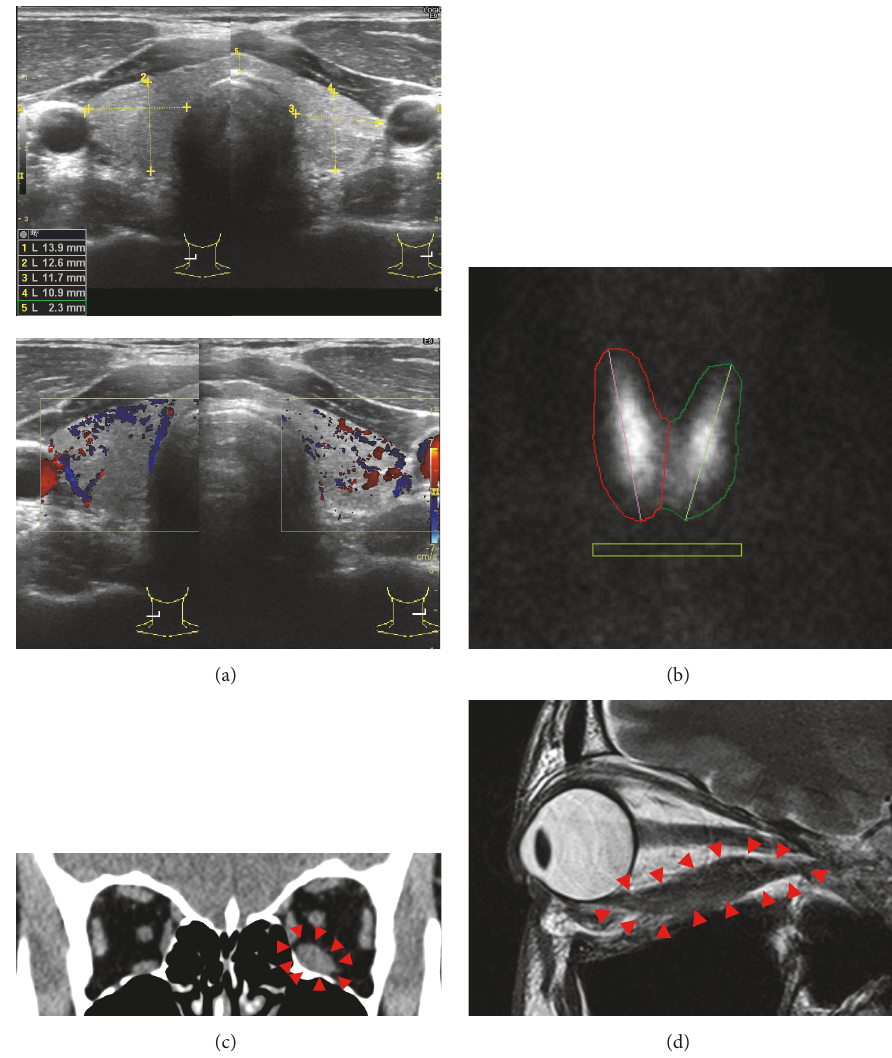
Figure 1: Imaging studies. (a) Ultrasonographic images of the thyroid showing normal-sized gland with slightly enhanced blood flow. (b) 99 m Tc scintigraphy exhibiting an uptake within the normal range. (c) CT scan image showing enlarged inferior rectus muscle of the left eye. (d) Fat-suppression T2-weighted MRI image of the left eye showing inferior rectus muscle swelling with slightly high intensity signal of the muscle